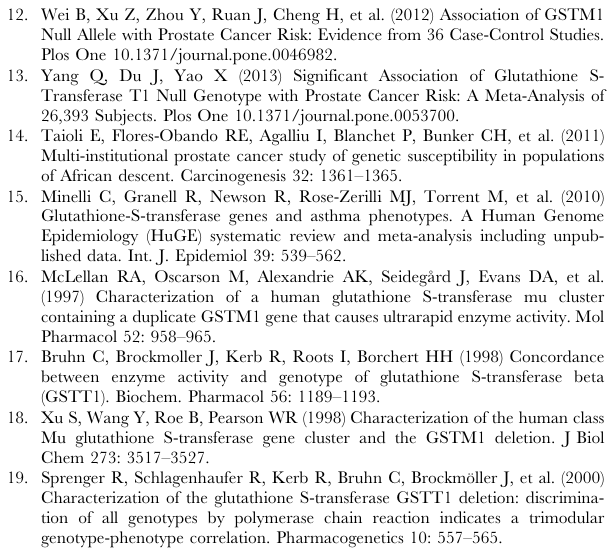
Table S2 Associations between GSTM1 genotype and subject characteristics. Table S3 Associations between GSTT1 genotype and subject characteristics. Table S4 Associations between combined GSTM1 and